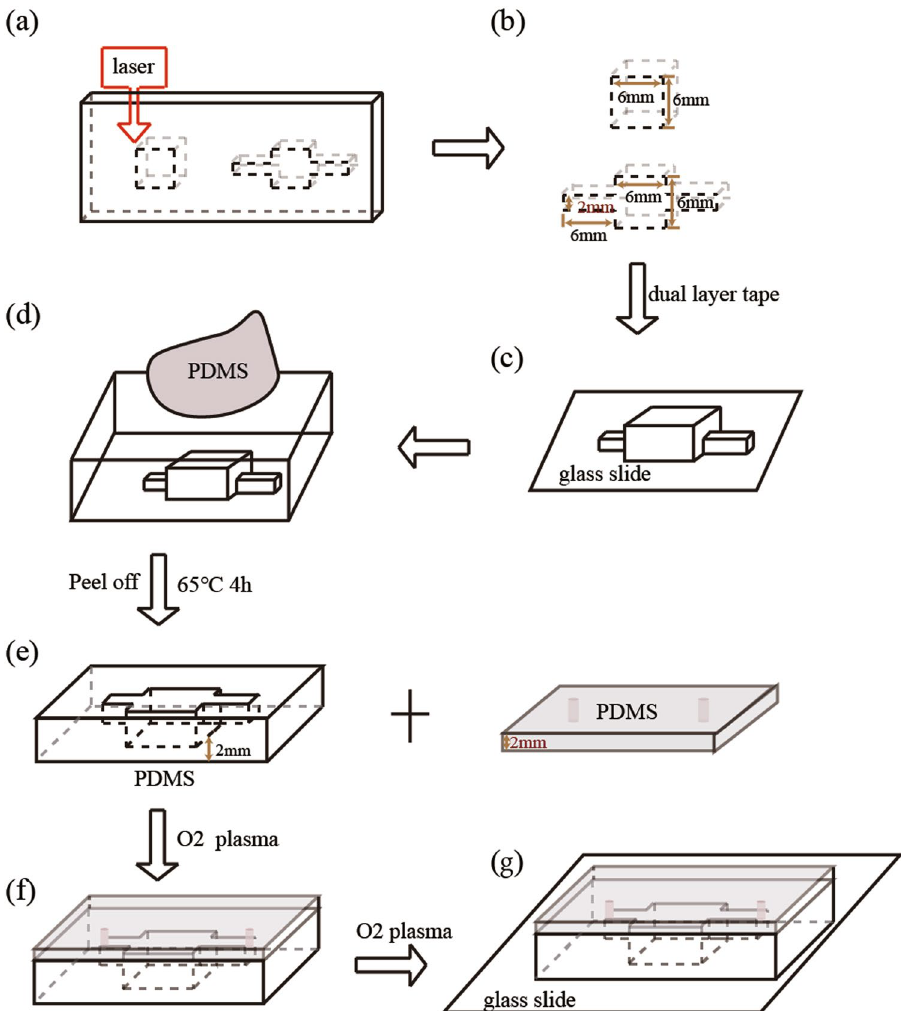
Figure 8. A step-by-step schematic diagram of the production of PDMS devices: ( a ) laser cutting of the PMMA board into the desired trench pattern, ( b , c ) fabrication of PMMA mold, ( c ) replication of trench pattern onto PDMS, ( d ) peeling of PDMS chamber from pattern, ( e ) fabrication of plain PDMS with inlet and outlet, ( f ) bonding of two pieces of PDMS by oxygen plasma, and ( g ) bonding of PDMS device to glass slide by oxygen